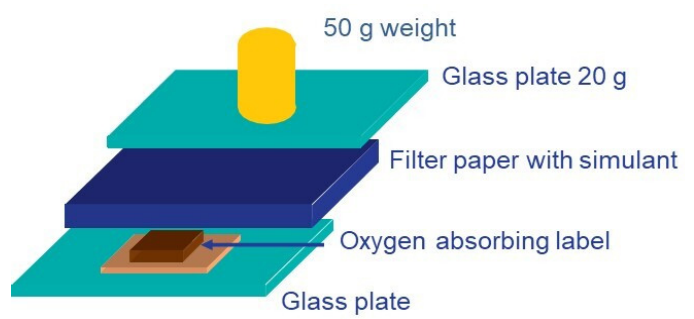
Figure 7. Graphical scheme of the dedicated migration test for oxygen scavenger (Dainelli et al.) [221]. Reprinted from [Elsevier], Copyright (2008), with permission from [221].